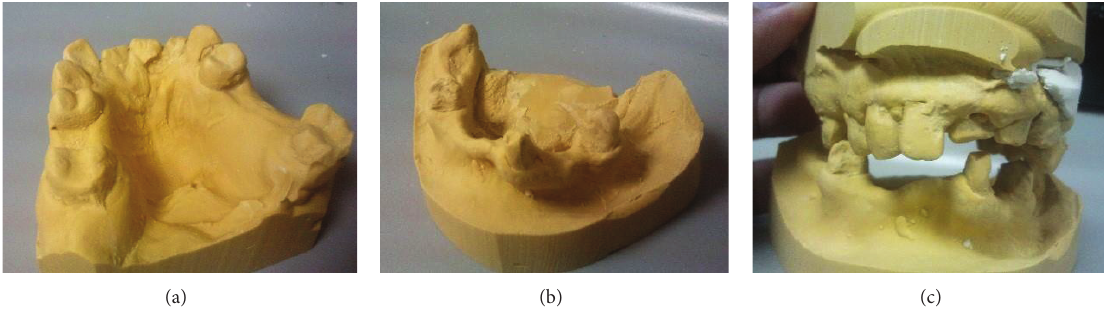
Figure 2: Study cast: (a) maxillary cast, (b) mandibular cast, and (c) both arches